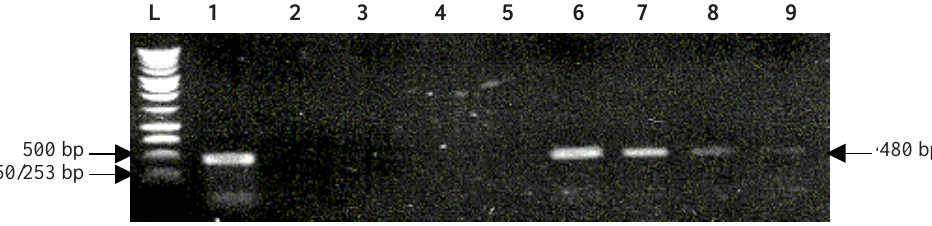
Fig. 2. Analysis by ELISA-RT-PCR of a serial dilution of the reverse transcription product starting from a crude extract of PVY infected pepper. L, 1 kb Ladder (Promega, Madison, WI, USA). Lane 1, PCR positive control (the pCR ® 2.1 vector with capsid sequence, as input). Lane 2, PCR negative control (tobacco leaf extract from healthy plant). Lane 3, crude leaf extract. Lanes 4 to 10: 1/10, 1/50, 1/100, 1/500, 1/1000 and 1/5000 (v:w) dilutions respec- tively in PBS of the RT product from the crude leaf extract sample.